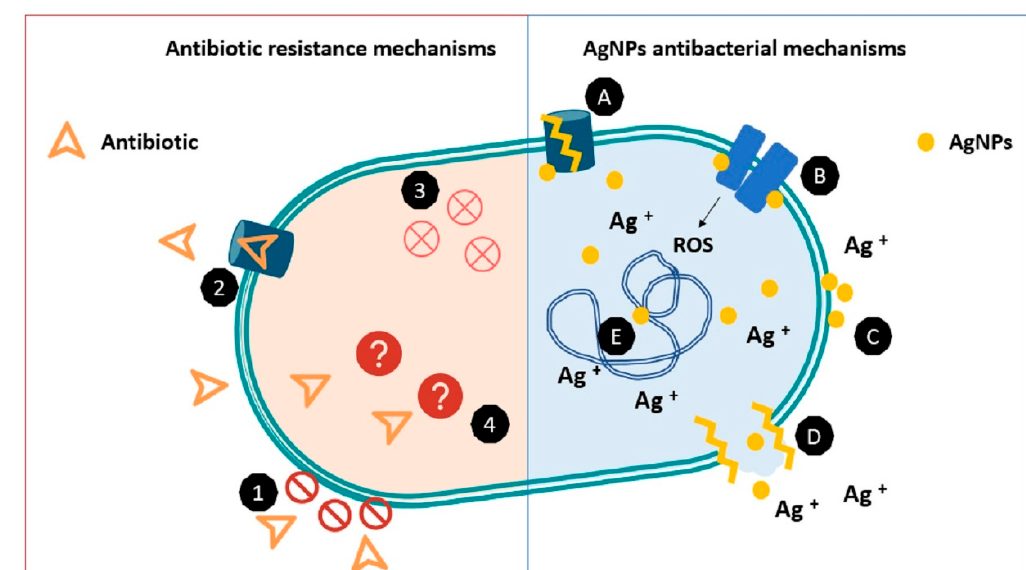
Figure 2. Comparative scheme between resistance mechanisms in bacteria vs antibacterial mechanisms of AgNPs. Antibiotic resistance mechanisms include: (1) permeation barriers, (2) efflux pumps, (3) inactivation of antibiotic, and (4) structural changes in antibiotic targets (represented as “?”) avoiding its recognition. On the other side AgNPs antibacterial mechanisms includes ( A ) alteration of efflux pumps, ( B ) disruption of membrane proteins and electron transport chains ( C ) accumulation in membrane affecting permeation, ( D ) disruption of membrane and leakage of intracellular content, ( E ) interaction and damage in DNA. A similar figure was published in [18].